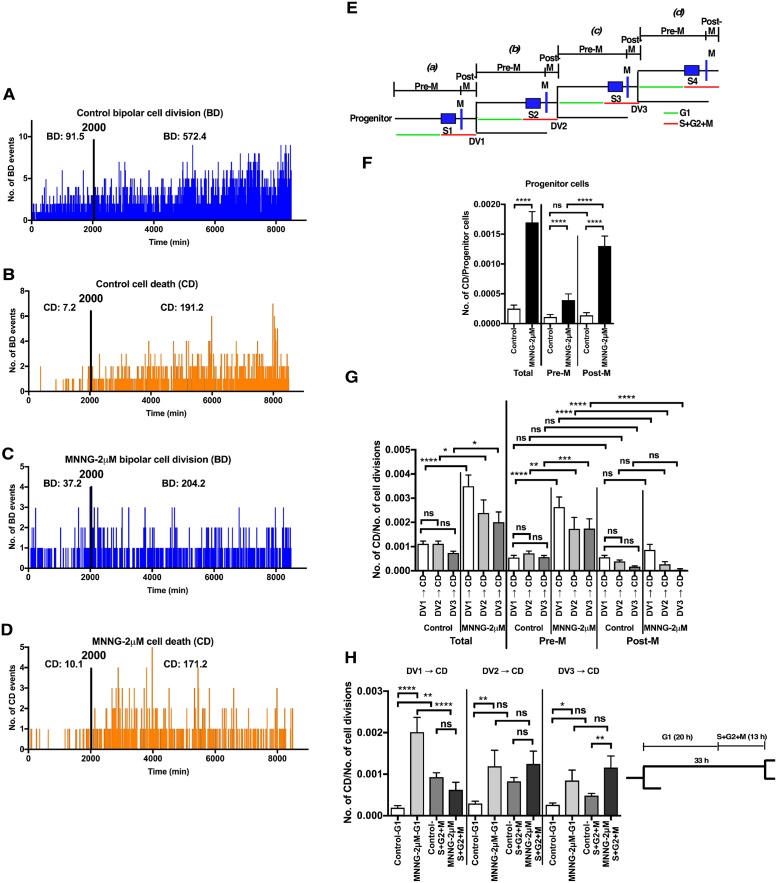
Analysis of cells exposed to MNNG-2μM.The numbers of BD (A and C) and CD (B and D) events occurring at each time point in Control cells (A and B) and cells exposed to MNNG-2μM (C and D) are plotted. The total numbers (per 100 cell lineages) of BD and CD events that occurred before and after 2000 min were determined (A-D). E. Definitions used in this Figure are listed. Progenitor cells (a) undergo the first S phase (S1), followed by mitosis (M) and the first cell division (DV1), and the periods before and after entering M are defined as Pre-M and post-M, respectively. Daughter (b), granddaughter (GD)(c), and grand-granddaughter (GGD)(d) cells undergo second, third, and fourth S phases (S2, S3, and S4, respectively). DV2 and DV3 represent the cell division of daughter and GD cells, respectively. Durations of G1 (green line) and S+G2+M (red line) are shown. F. The numbers of CD events occurring in progenitor cells (a) were normalized to the numbers of progenitor cells. Welch’s t-test was performed for Total; ****p<0.0001, and One-way ANOVA (Tukey’s multiple comparison test) was performed for Pre-M together with Post-M; ns: not significant and ****p<0.0001. Results shown as the mean ± SEM. G. The numbers of CD events that occurred in each cell lineage following DV1, DV2, and DV3 were determined, and, then, the numbers were normalized to the numbers of cell divisions (DV1, DV2, and DV3, respectively), to adjust for the growth of cells. One-way ANOVA (Tukey’s multiple comparison test) for Total and another One-way ANOVA for Pre-M together with Post-M were performed; ns: not significant, *p<0.05, **p<0.01, ***p<0.001 and ****p<0.0001. Results shown as the mean ± SEM. F and G Total: the total numbers of CD events occurred in each cell lineage during Pre-M and Post-M. H. The cell doubling time of cells exposed to MNNG-2μM was assumed to be 33 h; the duration of S1+G2+M phases was 13 h, and the duration of G1 was thus 20 h. CD events occurring during G1 and S+G2+M phases were determined. One-way ANOVA (Tukey’s multiple comparison test) for DV1 → CD, DV2 → CD and DV3 → CD was independently performed; ns: not significant, *p<0.05, **p<0.01, and ****p<0.0001. F-H. Sample sizes of Control and MNNG-2μM were 330 and 188, respectively. Results shown as the mean ± SEM.